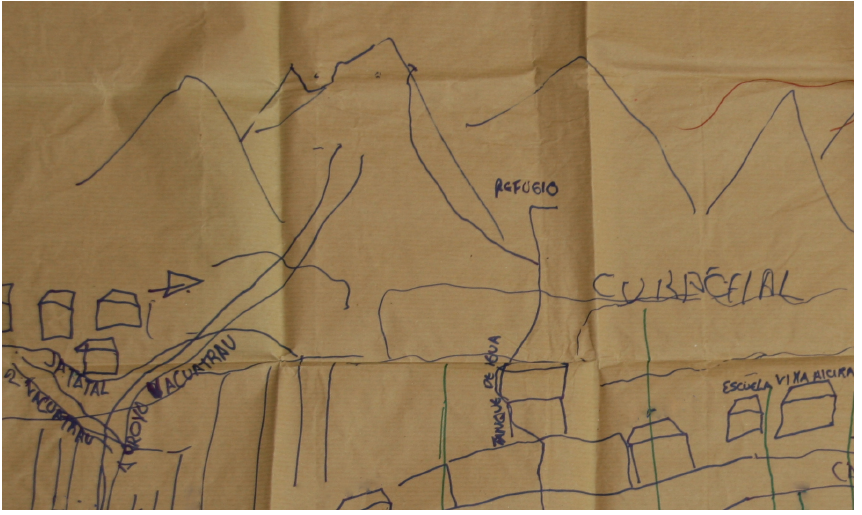
Figure 3. Example of a sketch map with a sideways